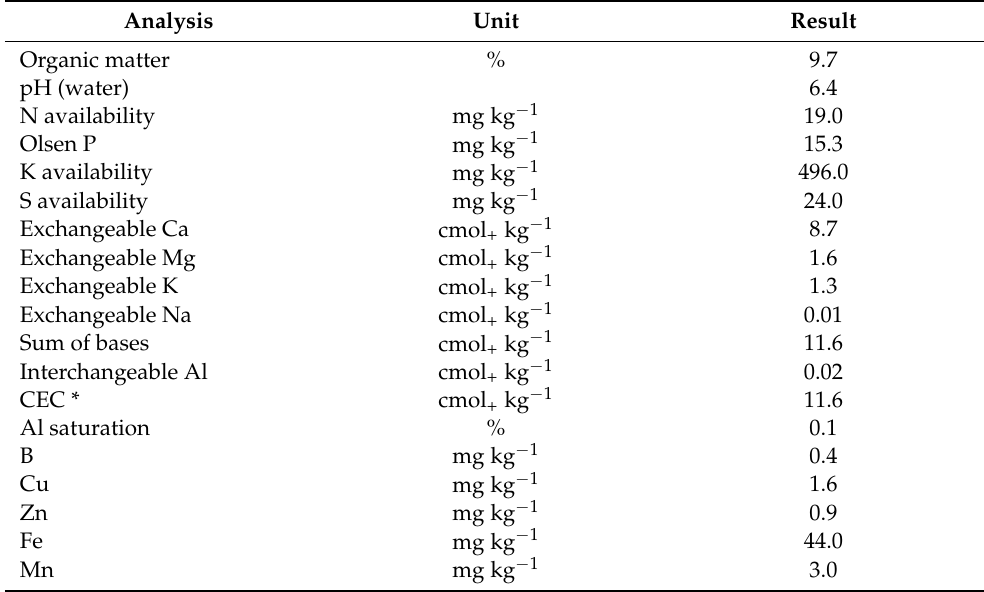
Table 1. Soil chemical analysis of the study site in the Ñuble Region of Chile.